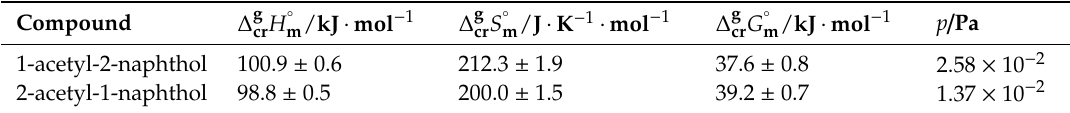
Table 2. Standard ( p of sublimation, and vapor pressure, p , at T = 298.15 K, for 1-acetyl-2-naphthol and 2-acetyl-1-naphthol 1